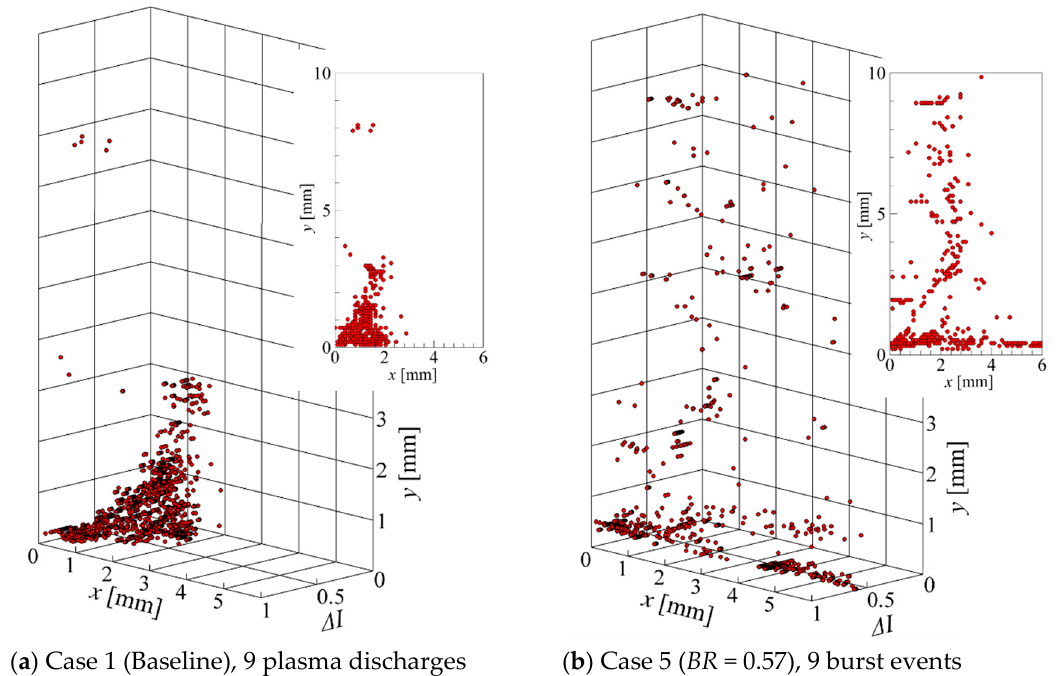
Figure 13. The location of the hot spot.